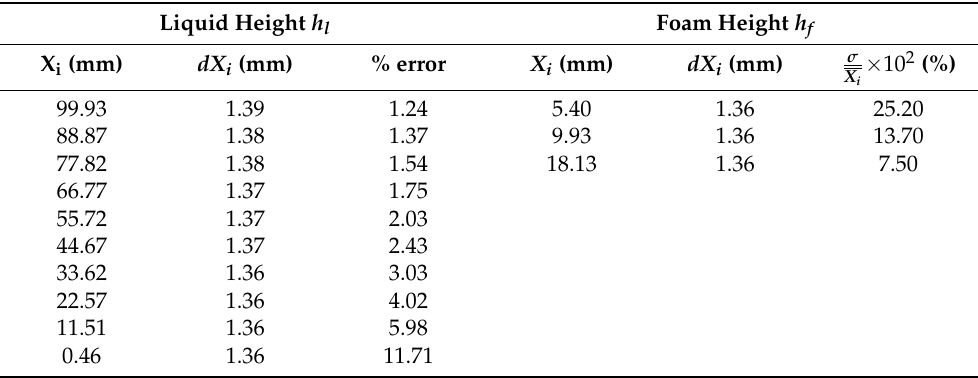
Table 5. Uncertainties dX i and the relative uncertainties σ foam height h f